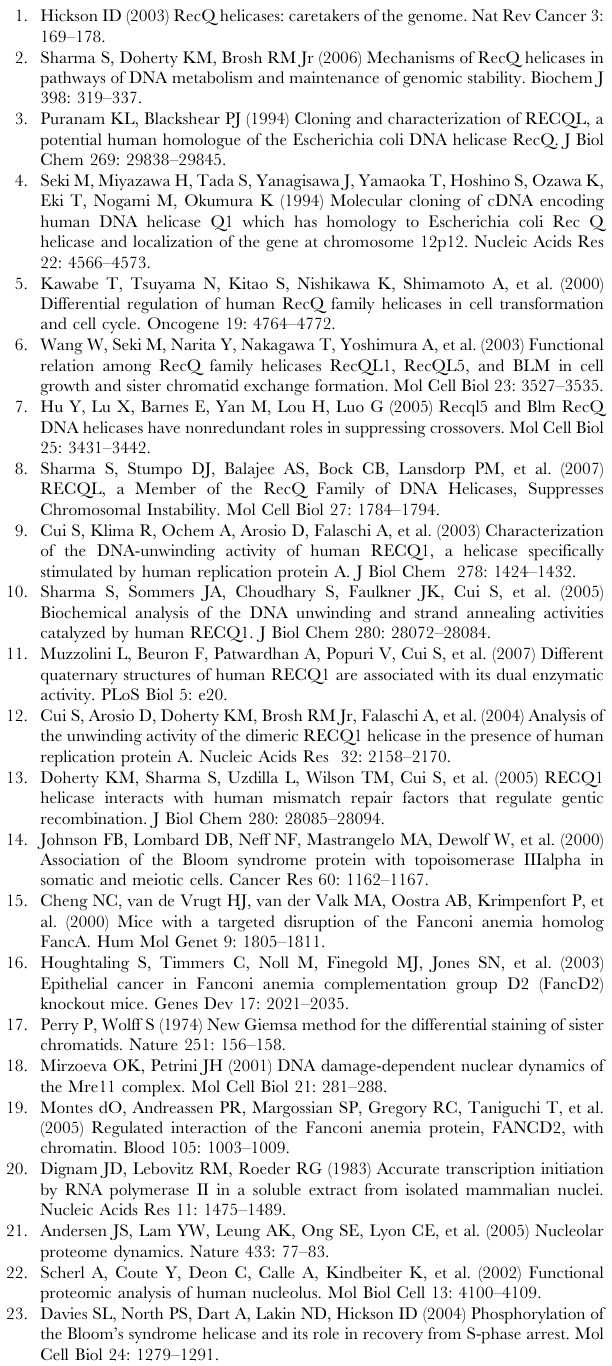
Figure S1 Supplementary Data